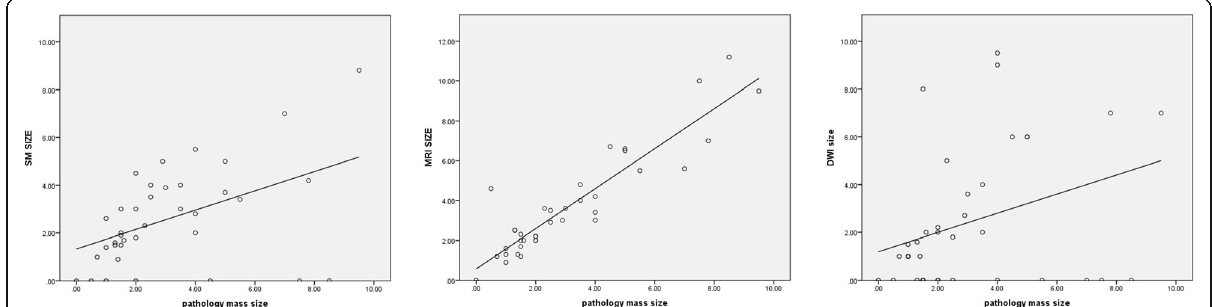
Fig. 2 Scatter dot figure showing the relation between the measured lesion size in different imaging modalities and the postoperative pathology lesion